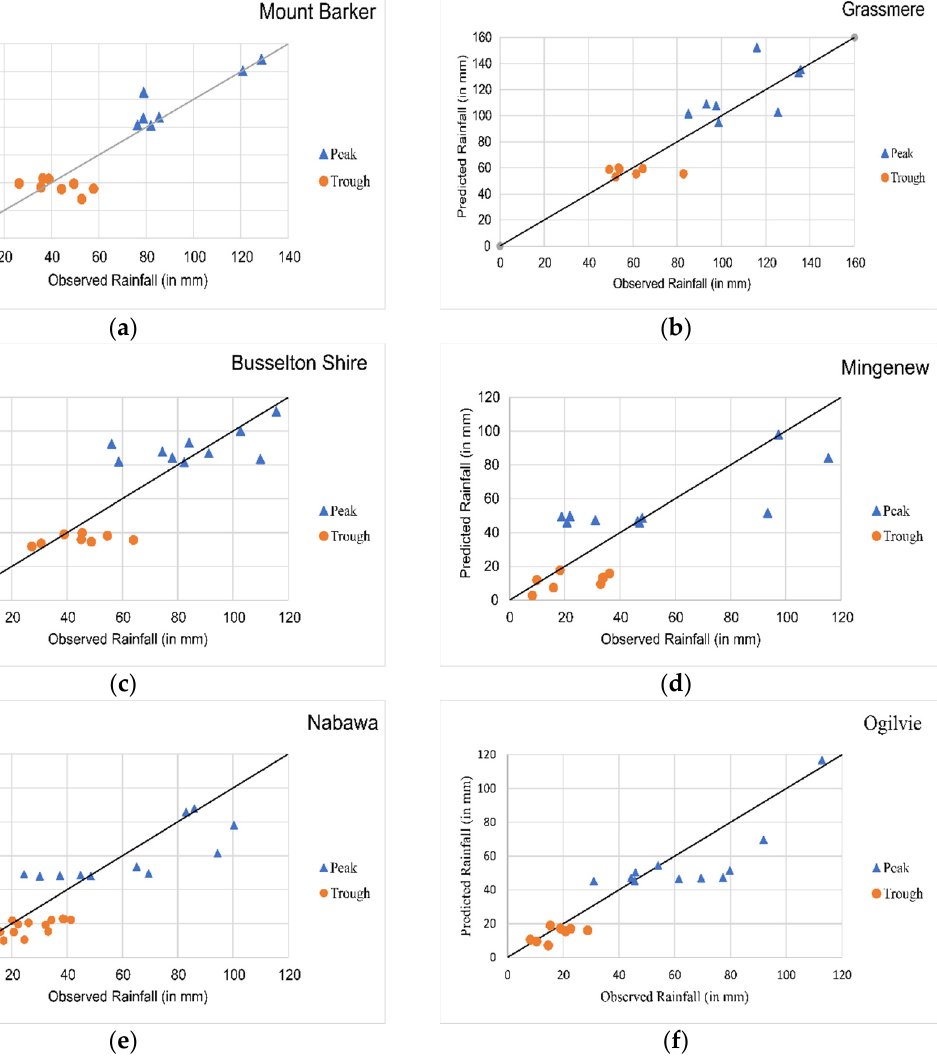
Figure A4. Peak and trough detection using ARIMAX model for ( a ) Mount Barker; ( b ) Grassmere; ( c ) Busselton Shire; ( d ) Mingenew; ( e ) Nabawa; ( f ) Ogilvie.